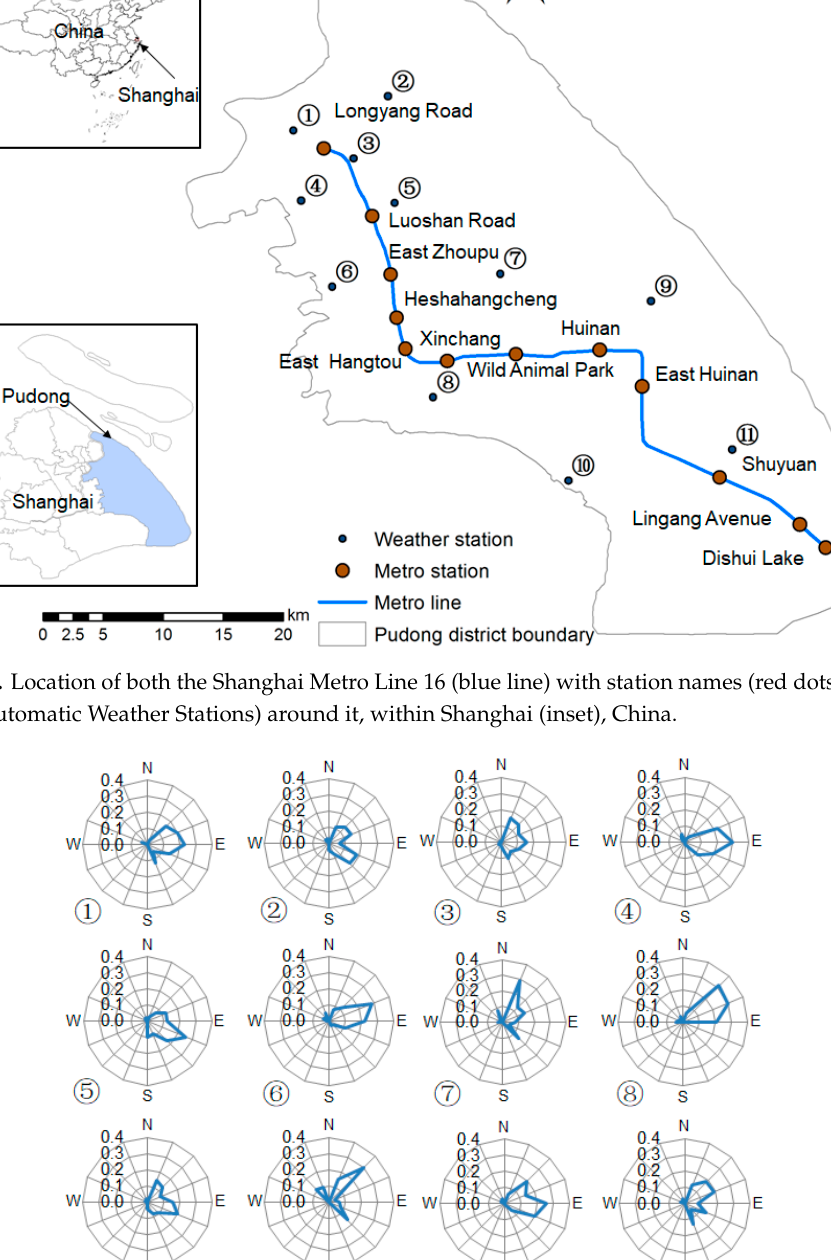
Figure 3. Steps to evaluate rail transport safety within the wind risk warning model for rail transport (WR2). 3.1. Wind Field Accurate wind velocity and direction at the rail carriage position are critical but NWP data usually have low spatial resolution (e.g., ECMWF (European Centre for Medium-Range Weather Forecasts data are at 0.125° resolution (~12 km)) that are too coarse for rail transport risk assessment. Similarly, observational networks cannot always satisfy data needs as AWS networks are sited for a variety of purposes, which may not be consistent with decision-making for railway operations. The local roughness length ( z 0_local ) and zero plane displacement ( z d_local ) influence the wind load on a rail vehicle. To calculate these the mean roughness, the element height ( H av ) is obtained from the ASTER (advanced space borne thermal emission and reflection radiometer) global digital elevation model (GDEM V1, resolution = 30 m) [26]. The “rule of thumb” morphometric method [27–30]: 0_